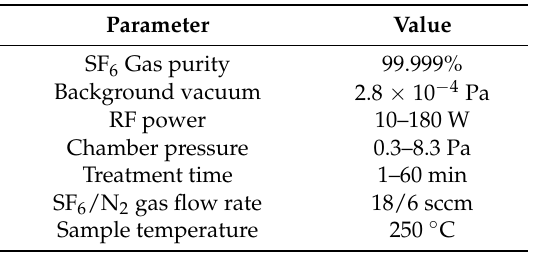
Table 1. The process parameters for